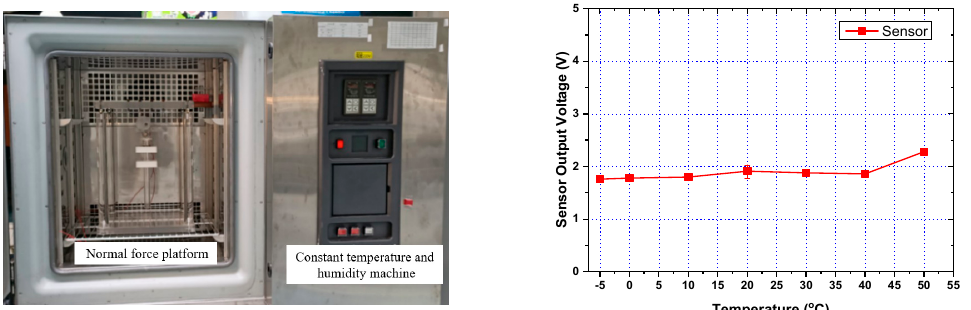
Figure 21. Picture of the humidity–controlled temperature chamber and the voltage output of the sensor in response to temperature changes.